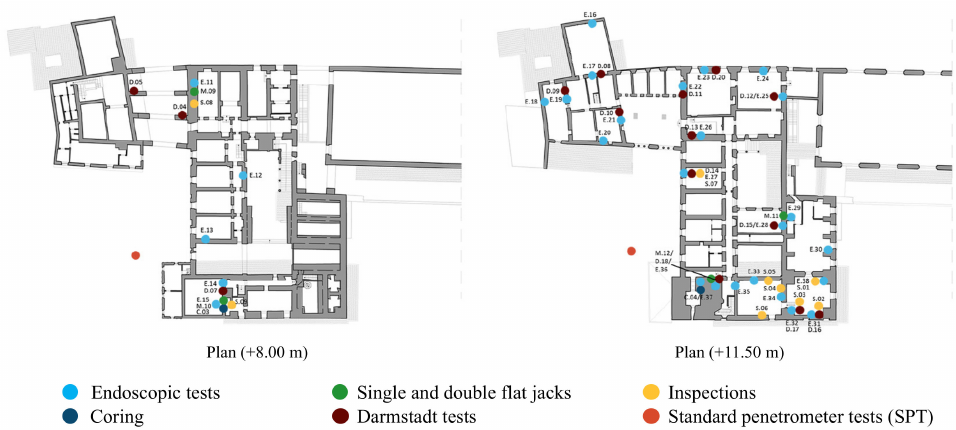
Figure 3. Location in plan of some available in-situ tests carried out at the 3rd and 4th levels.